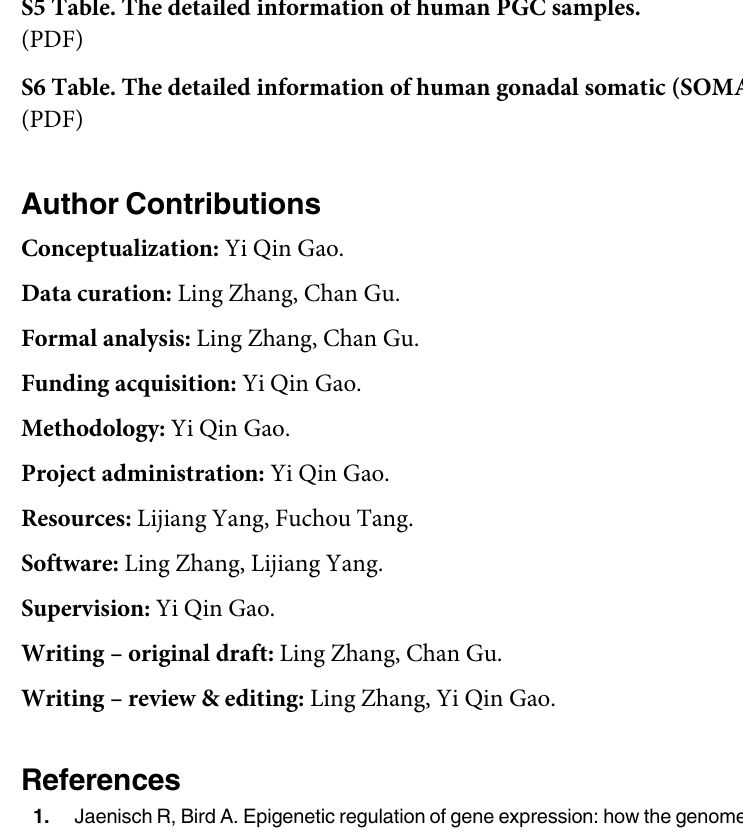
S4 Table. The detailed information of human somatic cell samples. S5 Table. The detailed information of human PGC samples. S6 Table. The detailed information of human gonadal somatic (SOMA)